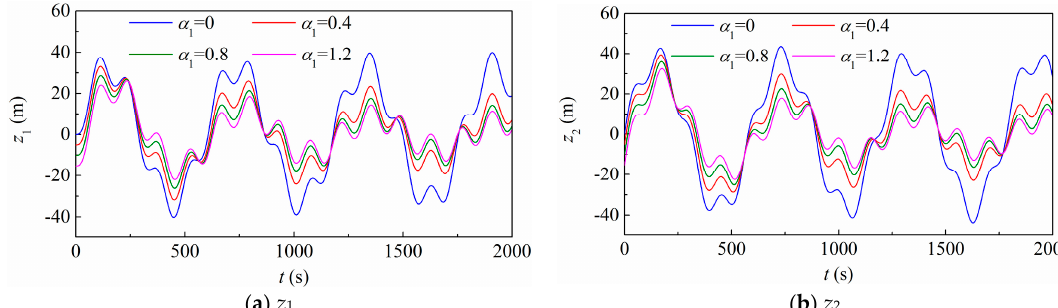
Figure 9. Effect of head loss on the highest water levels in surge tanks [62].